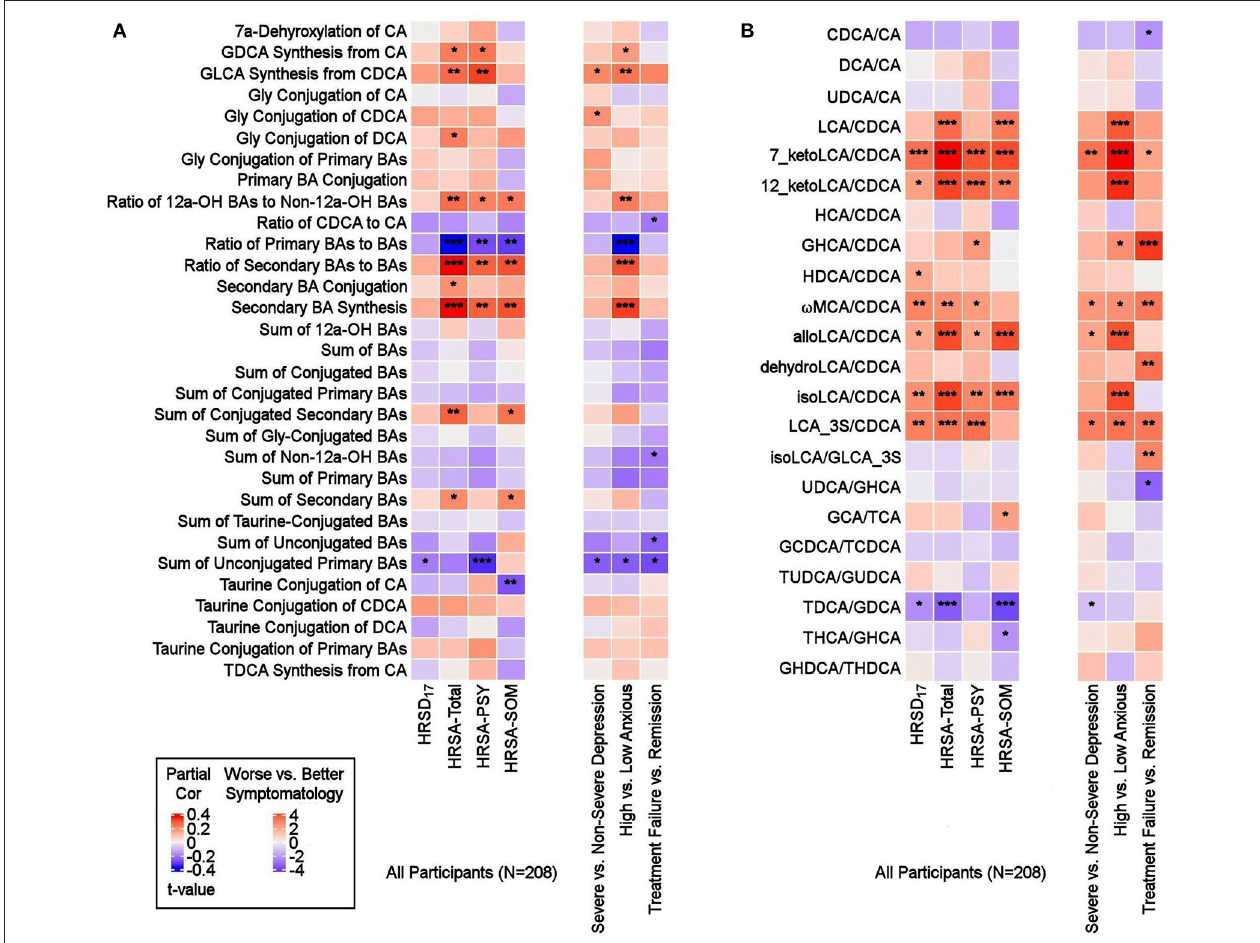
FIGURE 4 | Ratios of BAs reflective of liver and gut microbiome enzymatic activities in depressed patients. Three types of ratios (pairwise or composite) were calculated to inform about possible enzymatic activity changes in depressed participants. These ratios reflect one of the following: (1) Shift in BA metabolism from primary to alternative pathway. (2) Changes in gut microbiome correlated with production of secondary BAs. (3) Changes in glycine and taurine conjugation of BAs. (A) Composite Ratios and summations. (B) Selected Pairwise Ratios. For each figure, the left panel presents a heat map of partial Spearman rank correlations between BA ratios/summations and scores on the HRSD17 and Hamilton Anxiety scale and subscales, after accounting for age, sex, and body mass index, and the right panel presents a heat map of differences in ratios/summations in severe vs. non-severe depressed, high vs. low anxious and treatment-failure vs. remitter groups. BA, Bile Acid; CA, Cholic Acid; CDCA, Chenodeoxycholic Acid; DCA, Deoxycholic Acid; GCA, Glycocholic Acid; GCDCA, Glycochenodeoxycholic Acid; GDCA, Glycodeoxycholic Acid; GHCA, Glycohyocholic Acid; GHDCA, Glycohyodeoxycholic Acid; GLCA, Glycolithocholic Acid; GUDCA, Glycoursodeoxycholic Acid; HCA, Hydroxycitric Acid; HDCA, Hyodeoxycholic Acid; HRSA-PSY, Psychic anxiety subscore of the Hamilton Anxiety Rating Scale; HRSA-SOM, Somatic anxiety subscore of the Hamilton Anxiety Rating Scale; HRSA-Total, 14-item Hamilton Anxiety Rating Scale; HRSD 17 , 17-item Hamilton Depression Rating Scale (HRSD 17 ); LCA, Lithocholic Acid; MCA, Monocarboxylic Acid; TCA, Taurocholic Acid; TCDCA, Taurochenodeoxycholic Acid; TDCA, Taurodeoxycholic Acid; THCA, Tetrahydrocannabinolic Acid; THDCA, Taurohyodeoxycholic Acid; TUDCA, Tauroursodeoxycholic Acid; UDCA, Ursodeoxycholic Acid. *uncorrected p -value < 0.05. **uncorrected p -value < 0.01. ***uncorrected p -value <